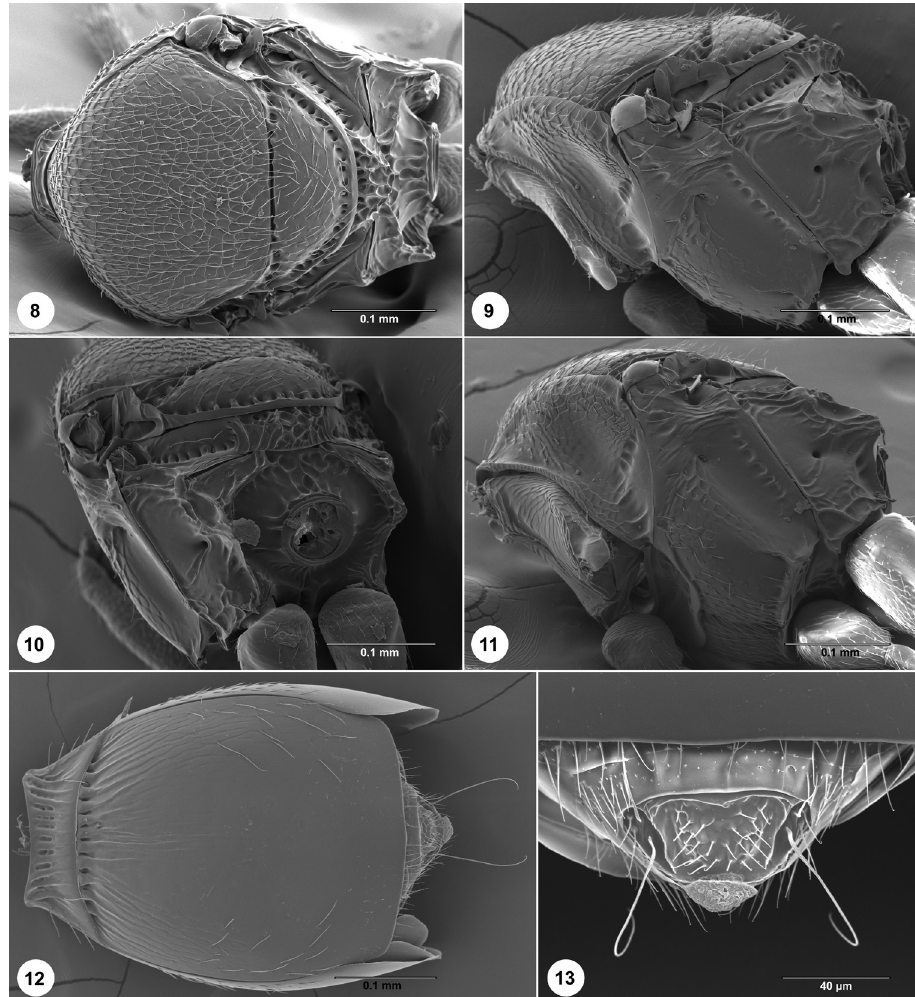
Figures 8–13. Telenomus fariai , female (FSCA 00091199) 8 mesosoma, dorsal view 9 mesosoma, lateral view 10 mesosoma, posterolateral view 11 mesosoma, ventrolateral view 12 metasoma, dorsal view 13 T6–T7, dorsal cus: foveate. Sculpture of metascutellum: rugose throughout. Metanotal trough: fove- ate, foveae less than half the lenght of the metanotum. Number of setae in metanotal trough: 3–4. Acetabular carina: present, wide and flat dorsally and directly posterior to fore coxa. Intercoxal space: greater than the length of fore coxa. Setation of ventral mes- opleuron: densely setose surrounding mesodiscrimen. Episternal foveae: absent. Sculp- ture of anteroventral mesopleuron: scaly reticulate microsculpture. Sculpture of femoral depression: smooth. Mesopleural carina: weakly indicated in posteroventral corner of mesopleuron. Prespecular sulcus: indicated by shallow foveae. Sculpture of speculum: